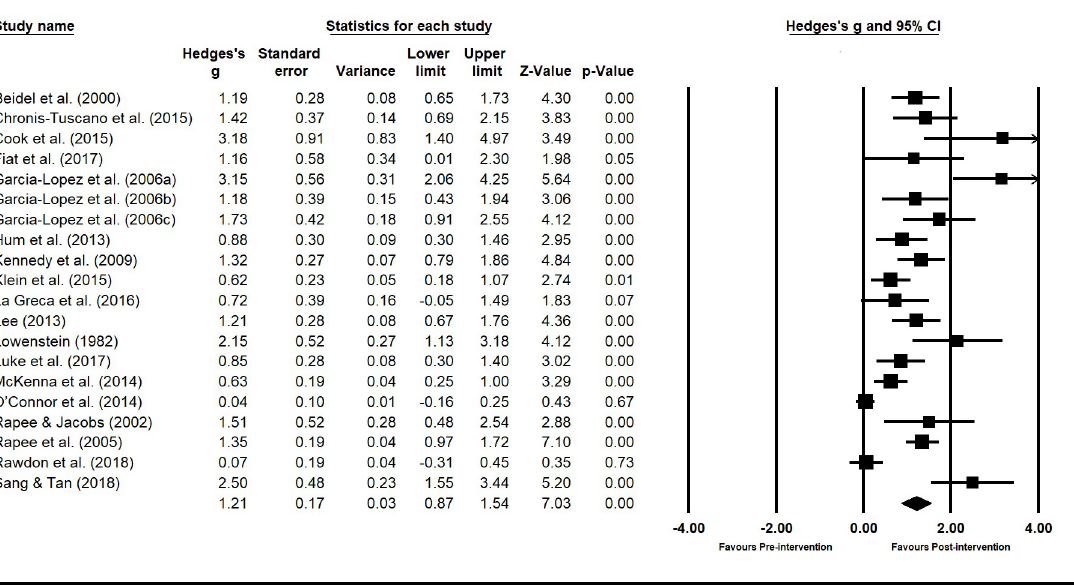
Fig 2. Within-group pre-post intervention